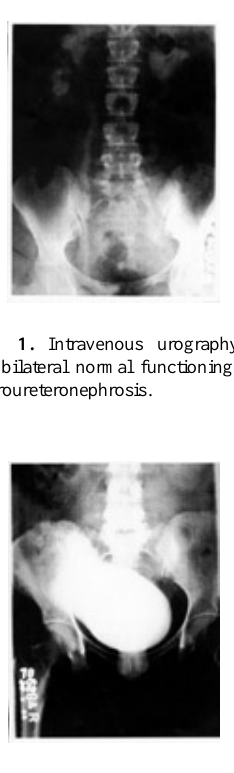
FIGURE 2 . Voiding cystourethrogram (VCUG) showing the dilated posterior urethra with a constriction ring in the distal urethra (spinning top